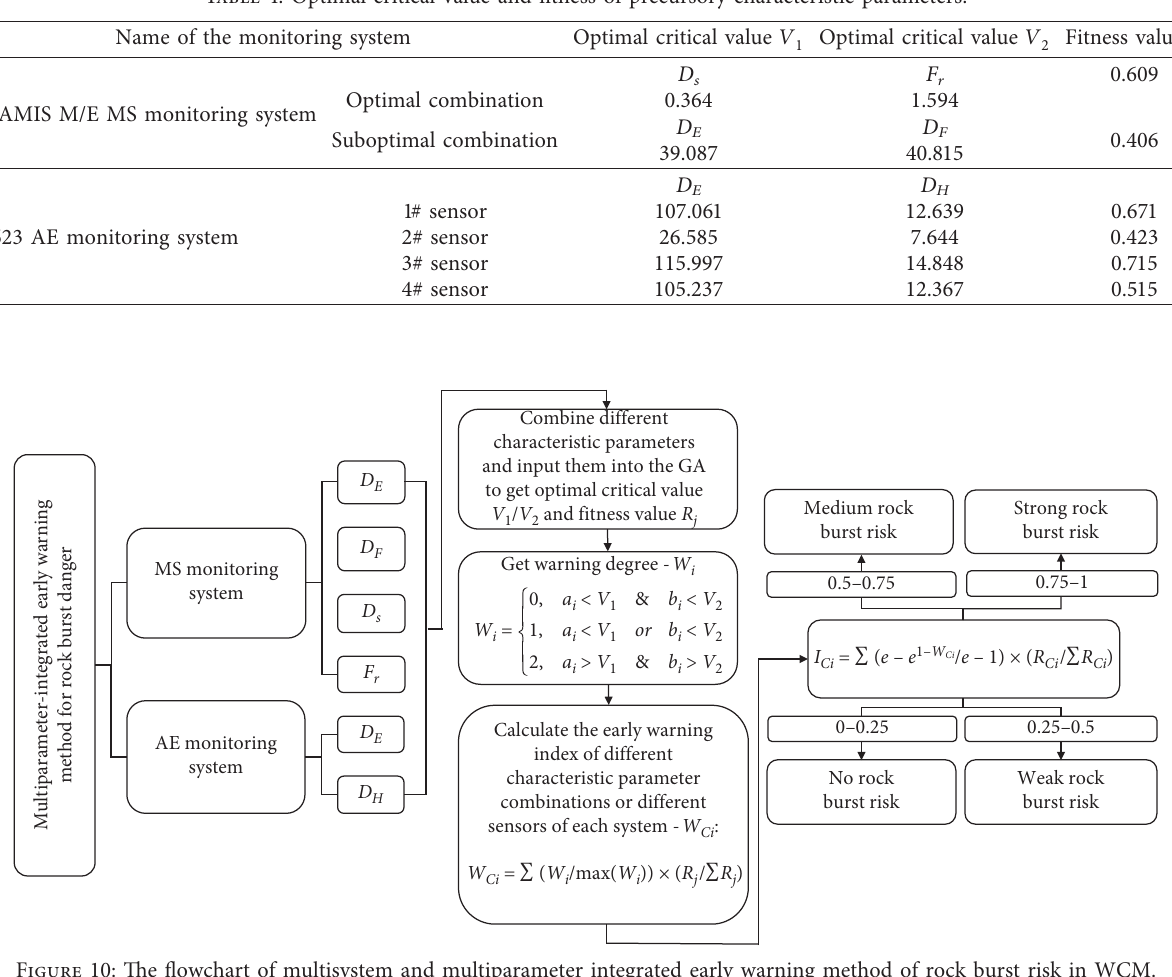
Table 4: Optimal critical value and fitness of precursory characteristic parameters.